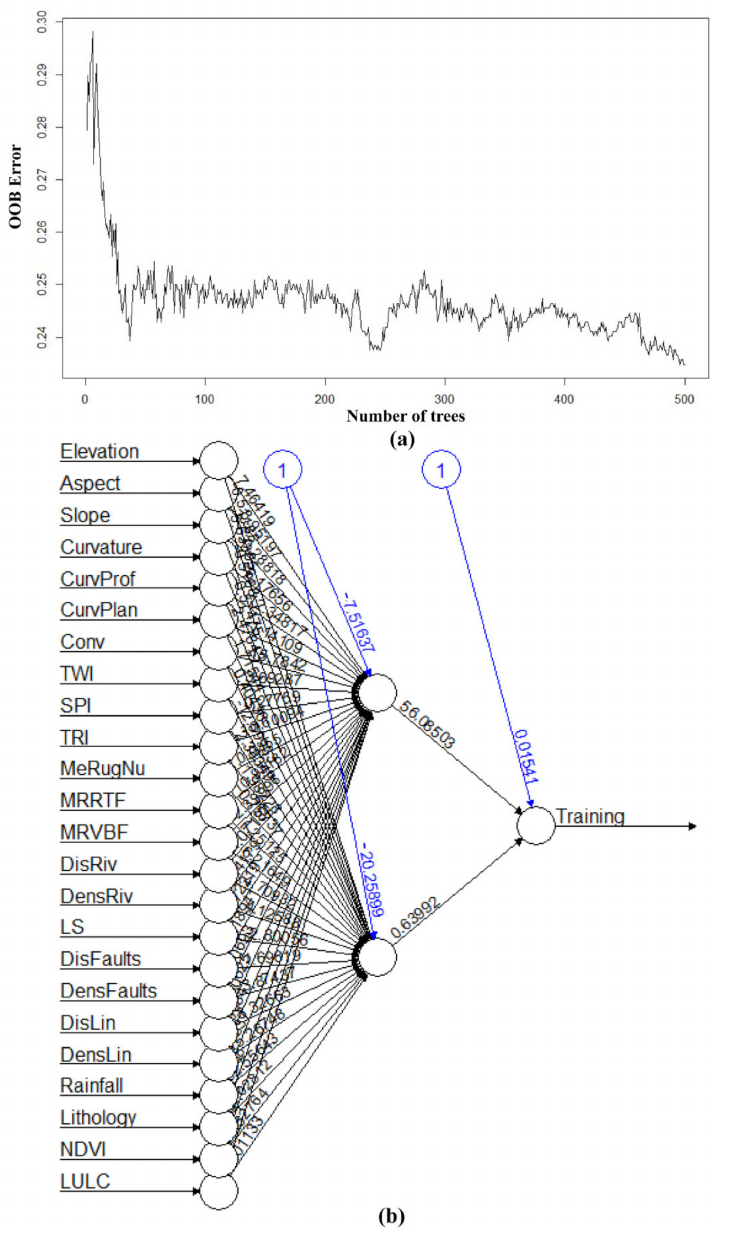
Figure 7. Number of trees optimized based on OOB estimates of the error rate in RF model ( a ) and diagram of ANN model ( b